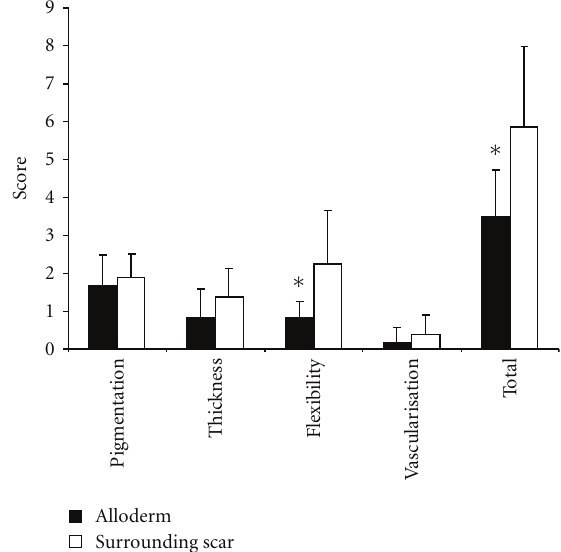
Figure 1: Comparison of scar qualities of the Alloderm implant sites and surrounding tissue by the modified Vancouver Burn Scar Index